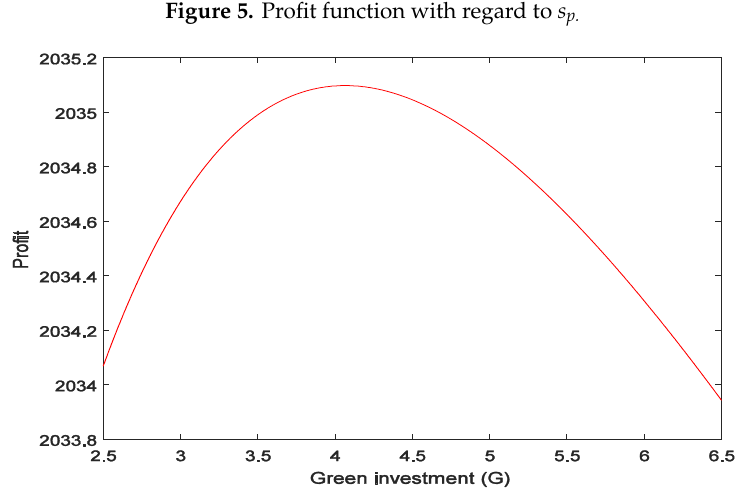
Figure 6. Profit function with regard to G.